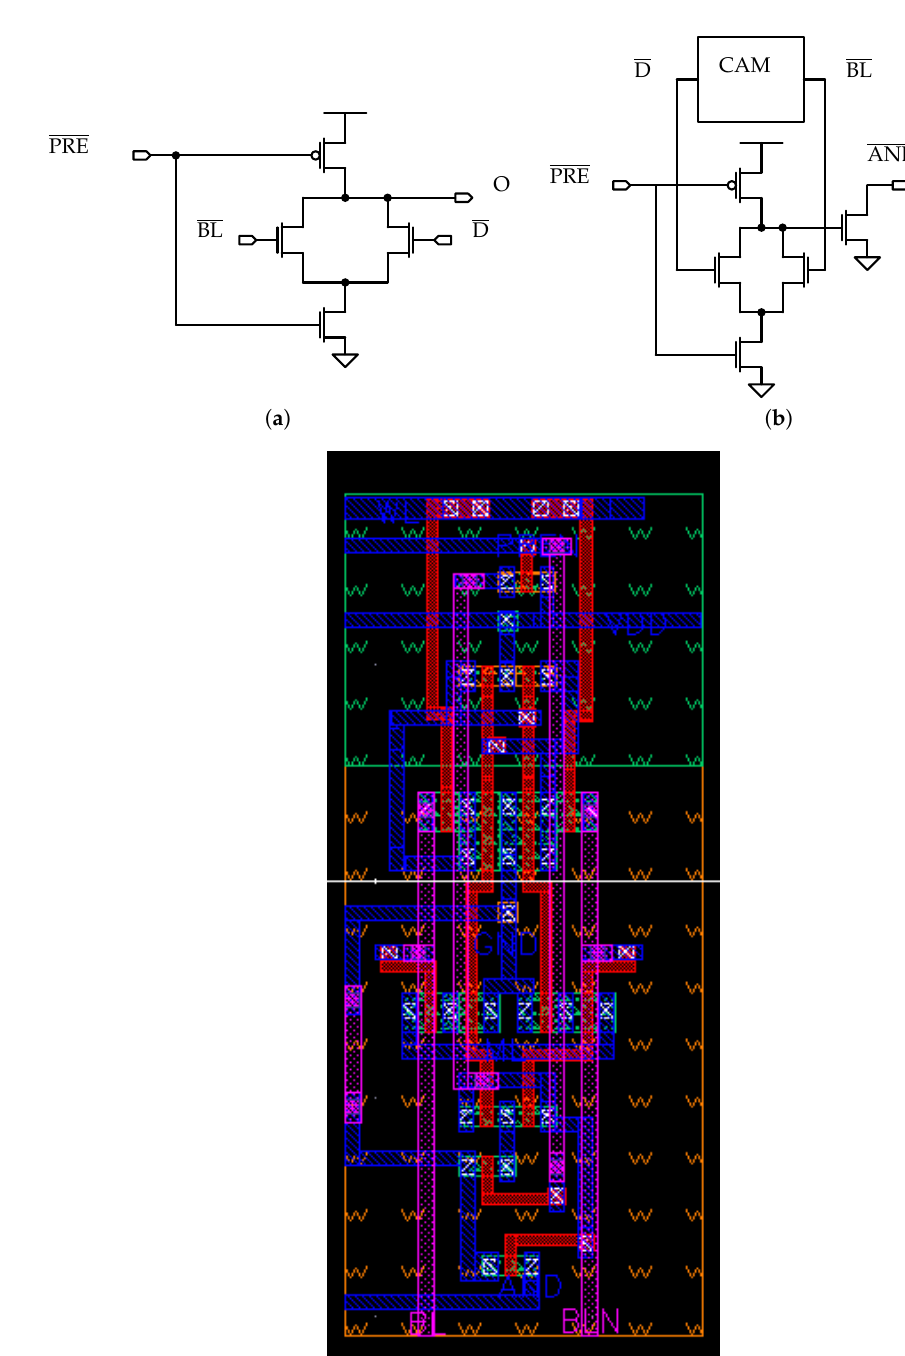
Figure 8. The dynamic AND gate and the cell in which it is integrated. ( a ) The dynamic AND gate. By using the negated values of the cell content, D, and the mask bit, BL, it is possible to take advantage of boolean logic laws to obtain an AND gate without adding an inverting stage on the output. ( b ) The memory cell that embeds the dynamic AND gate and the pull-down transistor of the AND line. It can be noticed that the output of the AND gate is negated using a single pull-down transistor, which output corresponds to the AND signal associated to the line. ( c ) The cell